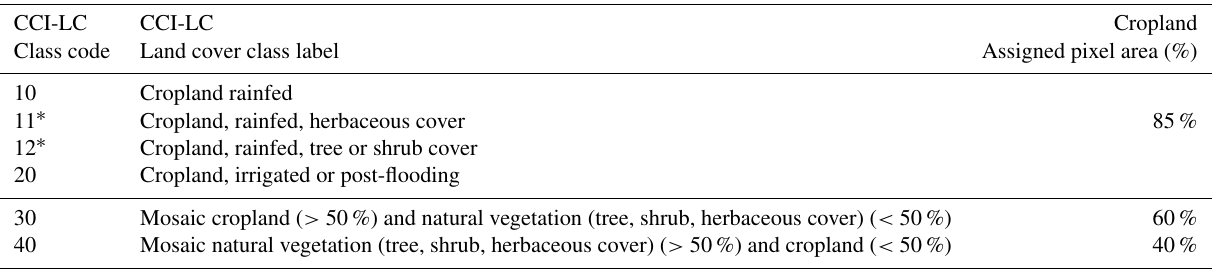
Table 1. Proportion of area of relevant CCI-LC pixels corresponding to land use